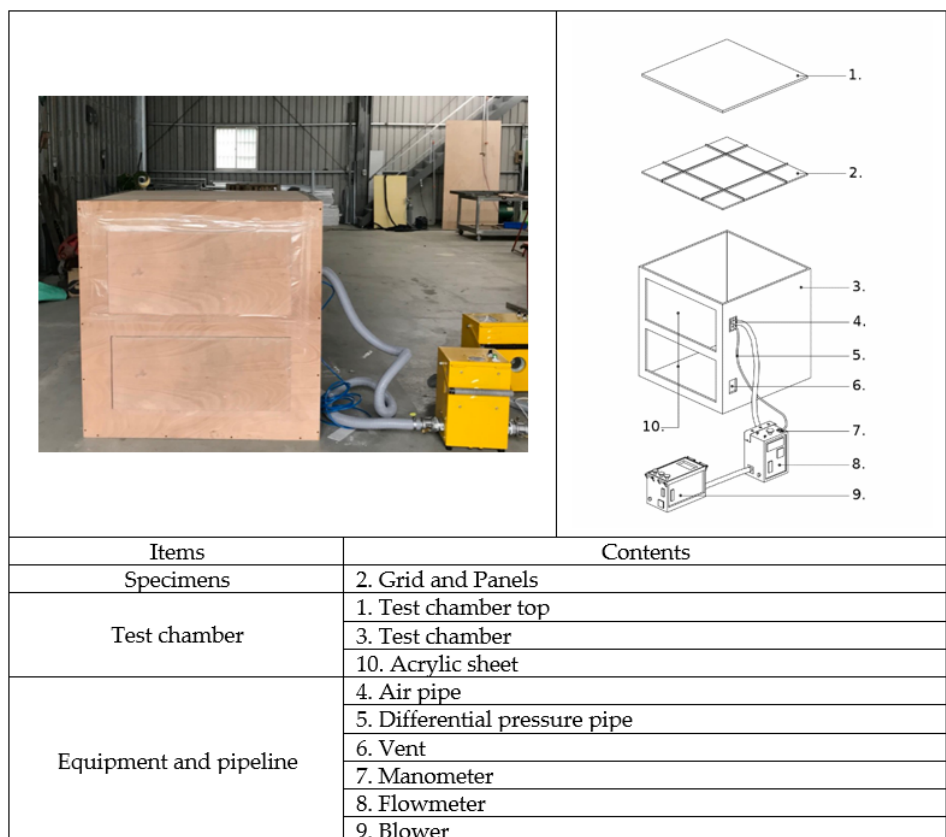
Figure 2. Test equipment